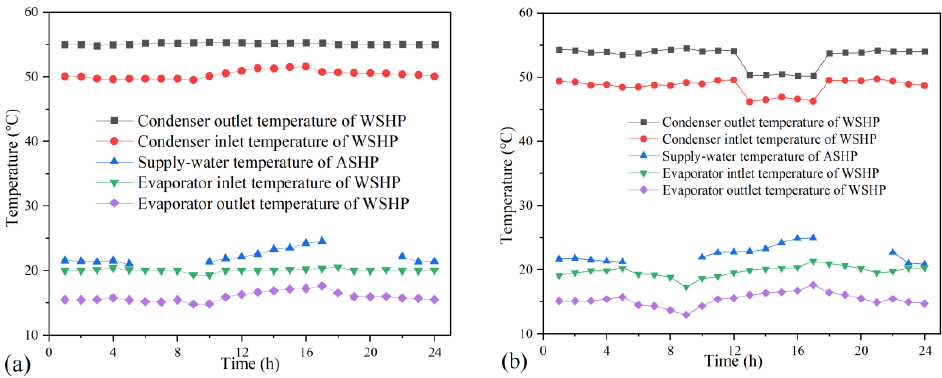
Figure 9. Water temperatures ( a ) simulated, ( b ) tested.